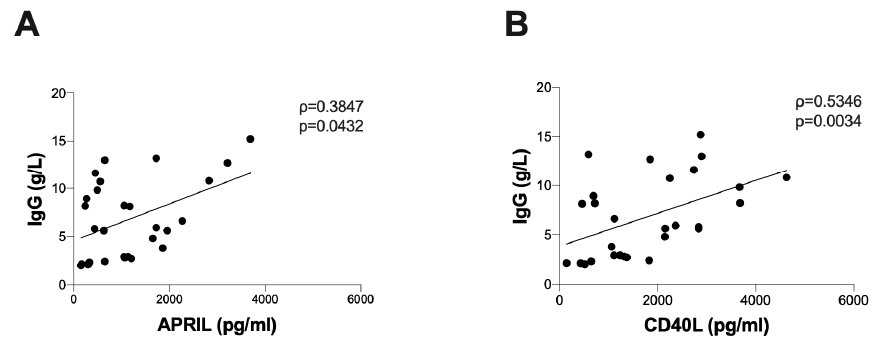
Figure 4. Correlations between plasma IgG and APRIL and CD40L levels. ( A ) Positive correlation between APRIL and IgG plasma levels. Linear correlation was evaluated by using the regression test, R 2 = 0.2285 p = 0.0101. ( B ) Positive correlation between plasma CD40L and IgG levels. Linear correlation was evaluated by using the regression test, R 2 = 0.1975 p = 0.0178. All correlations were performed using the Spearman test. The Spearman coefficient ( ρ ) and statistical significance (p) are reported in the graphics. IgG: immunoglobulin G; APRIL: a proliferation-inducing ligand; CD40L: CD40